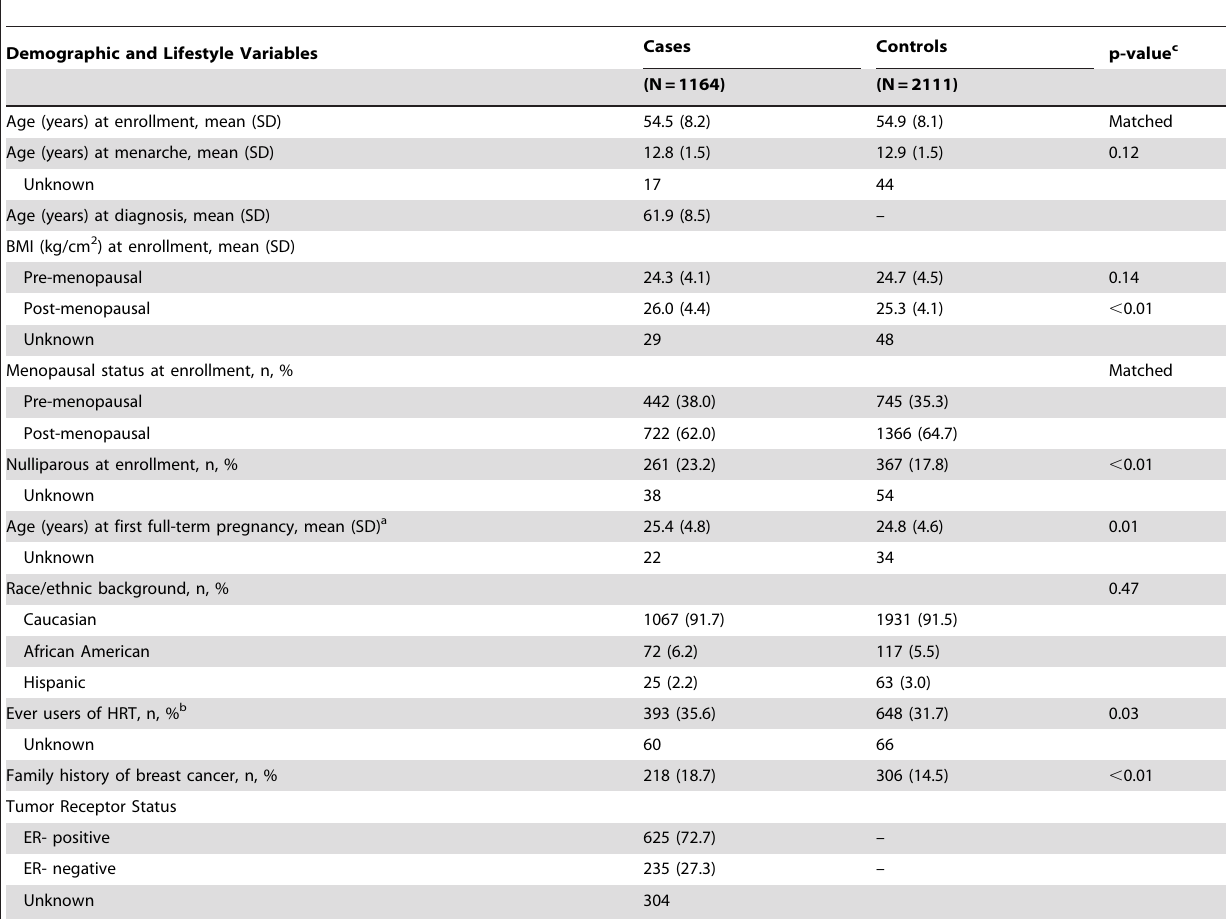
Table 1. Distributions of demographic and lifestyle variables by breast cancer status.